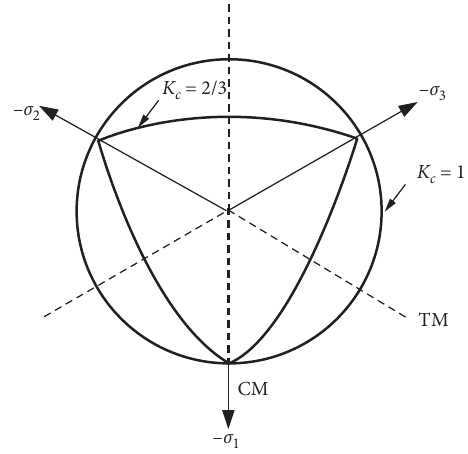
Figure 1: Deviatoric traces in the deviatoric plane.